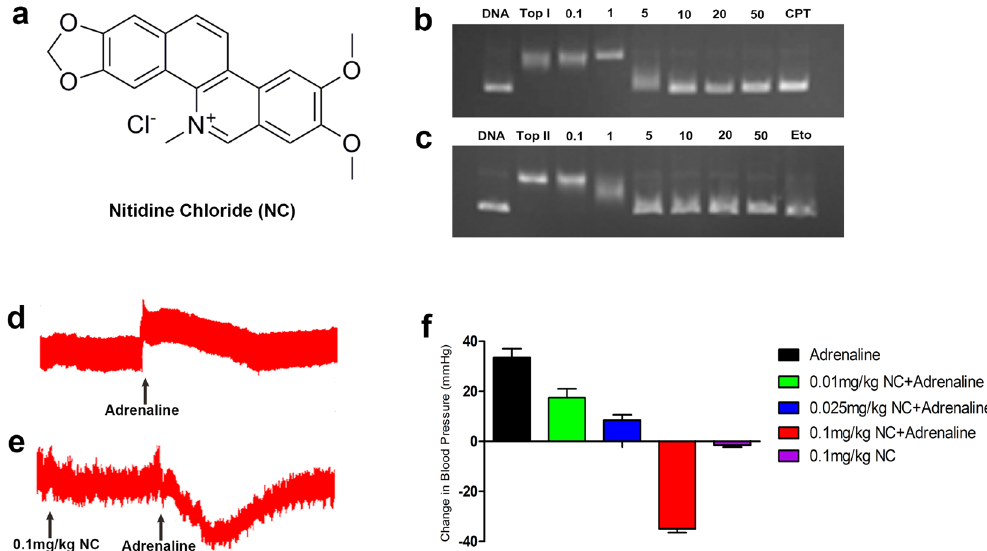
Figure 2. The results of validation experiments. ( a ) Chemical structure of NC. ( b ) Effect of NC on TopI mediated DNA relaxation indifferent concentration. Lane 1, supercoiled pBR322 plasmid DNA; lane 2, DNA + TopI; lane 3–8, DNA + TopI + NC (0.1, 1, 5, 10, 20, 50 μ M); lane 9, DNA + TopI + 50 μ M camptothecin. ( c ) Inhibition of TopII relaxation activity. Lane 1, supercoiled pBR322 plasmid DNA; lane 2, DNA + TopII; lane 3–8, DNA + TopII + NC (0.1, 1, 5, 10, 20, 50 μ M); lane 9, DNA + TopII + 50 μ M etoposide. ( d ) The effect of adrenaline (5 μ g/kg) on arterial blood pressure. ( e ) NC (0.1 mg/kg) caused reversal of the adrenaline pressor response. ( f ) The effect of NC (0.01, 0.025, 0.1 mg/kg) on the arterial blood pressure response to adrenaline.